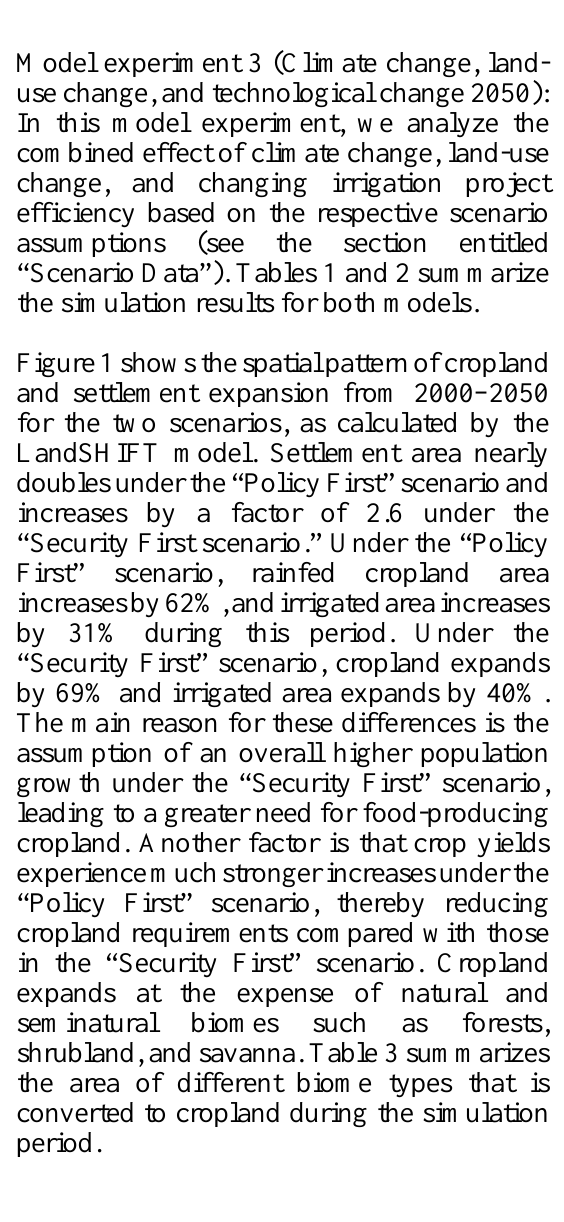
Table 2. Continental green and blue water fluxes for Africa as calculated in model experiments 1 and 3. Fluxes [km 3 /yr] Green water flux (evapotranspiration from rainfed part of cropland) Blue water flux (water withdrawals for irrigation)